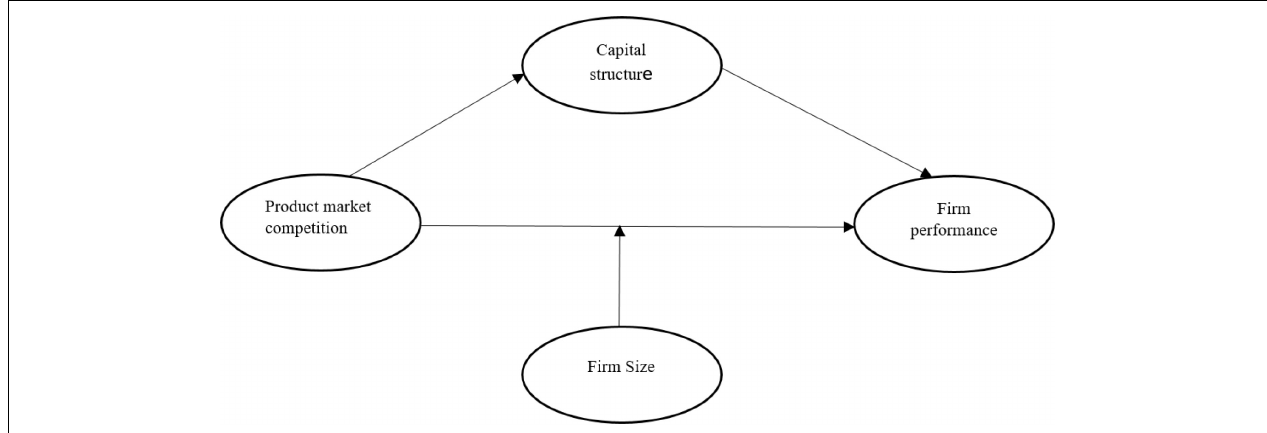
FIGURE 1 | Conceptual framework of the